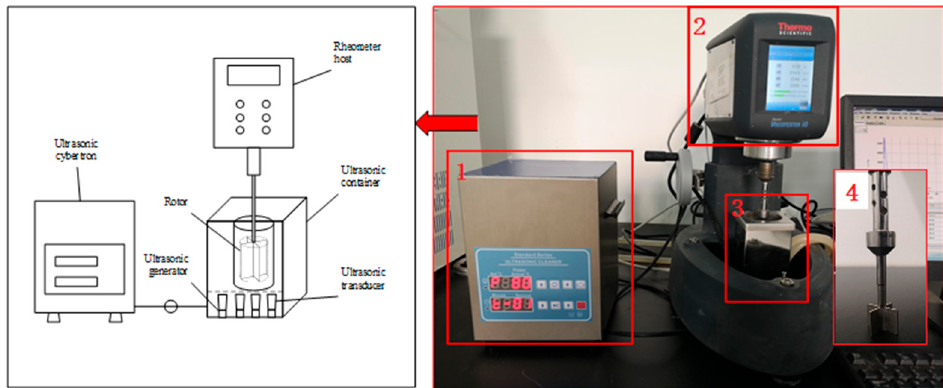
Figure 3. Rheometer and ultrasonic